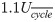
(a) Cycle-averaged velocity pattern at a threshold level of 1.1Ucycle¯ that is equivalavnt to 0.3 m/s used in [15]. (b) Systolic peak velocity pattern at a threshold level of 1.9Ucycle¯ that corresponds to 0.5 m/s used in the computational studies. (c) Cycle-averaged wall pressure map. The color bar range used here is ∼2.0 cycle-averaged pressure drop between the inlet and outlet of the aneurysm that corresponds to 75-90 mmHg used in the computations in [15]. (d) Wall pressure map at the systolic peak. The color bar range is ∼5.3 cycle-averaged pressure drop between the inlet and outlet of the aneurysm corresponding to 80-120 mmHg used in the computational studies.